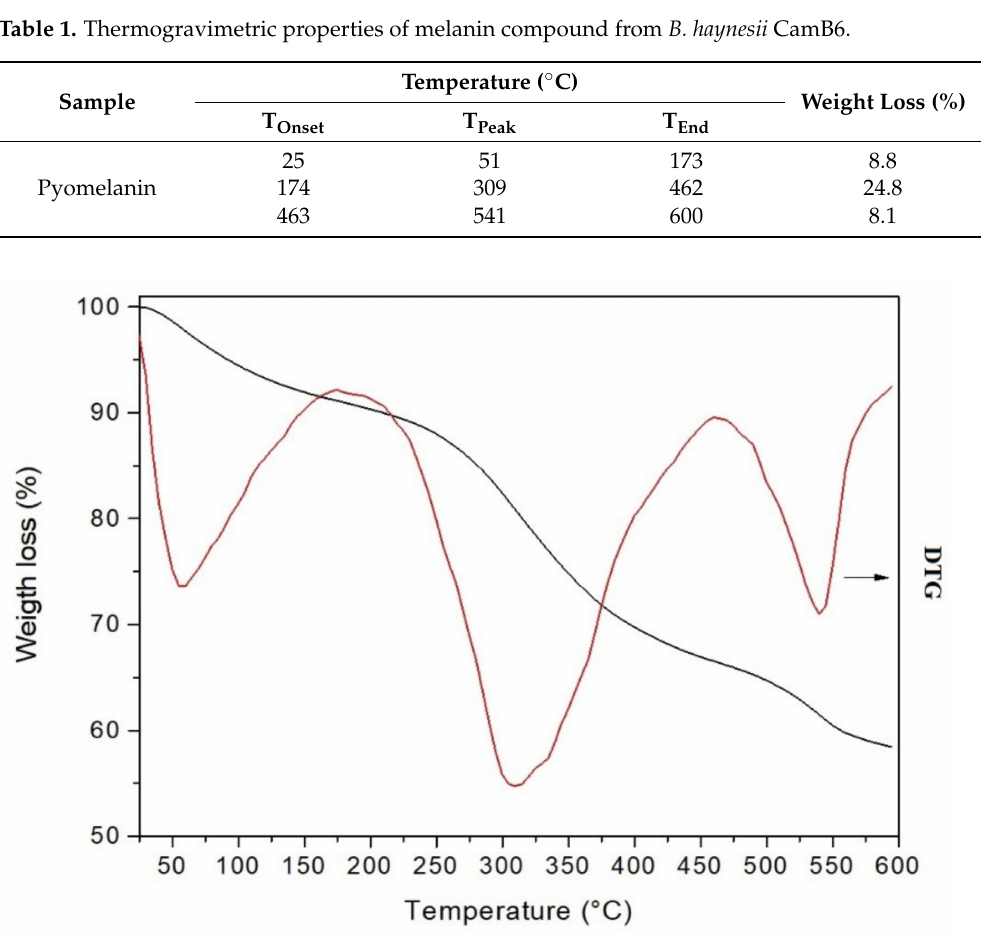
Figure 7. TGA (black line) and DTG (red line) curves of the melanin-like compound produced by B. haynesii CamB6 were recorded at 10 ◦ C/min under N 2 atmosphere (gas flow 50